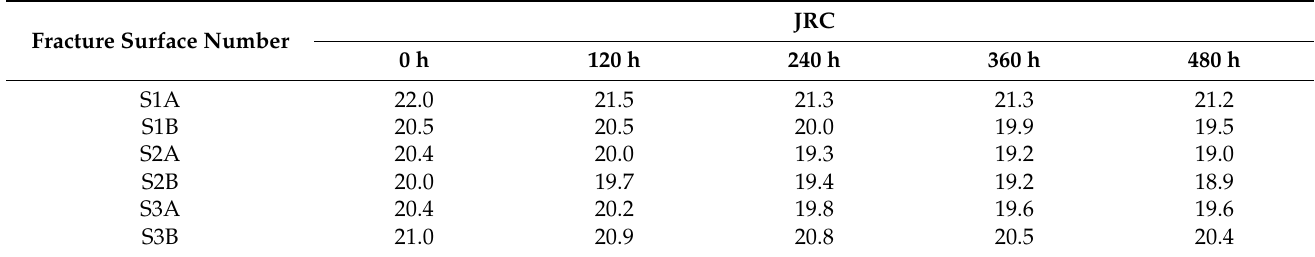
Table 2. Fracture surface JRC values at different leaching time.